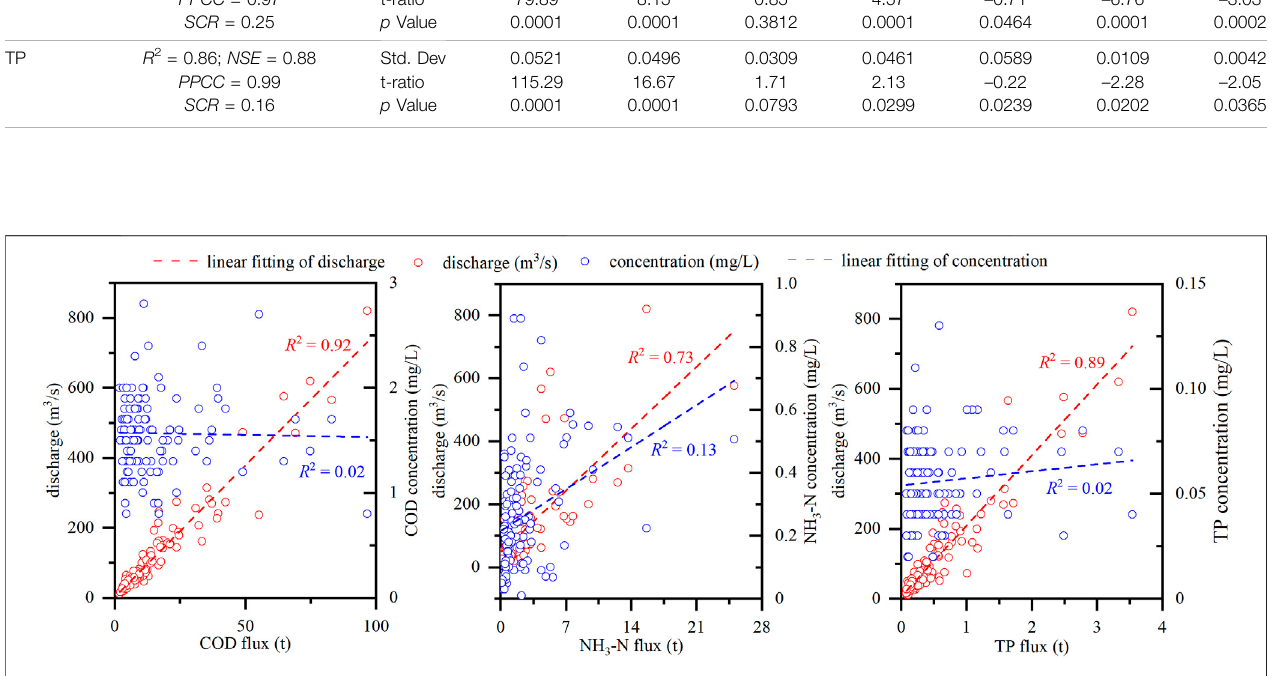
FIGURE 2 | Correlations of measured of COD, NH 3 -N, and TP fl uxes with discharge and water pollutant concentration of the Lijiang River.